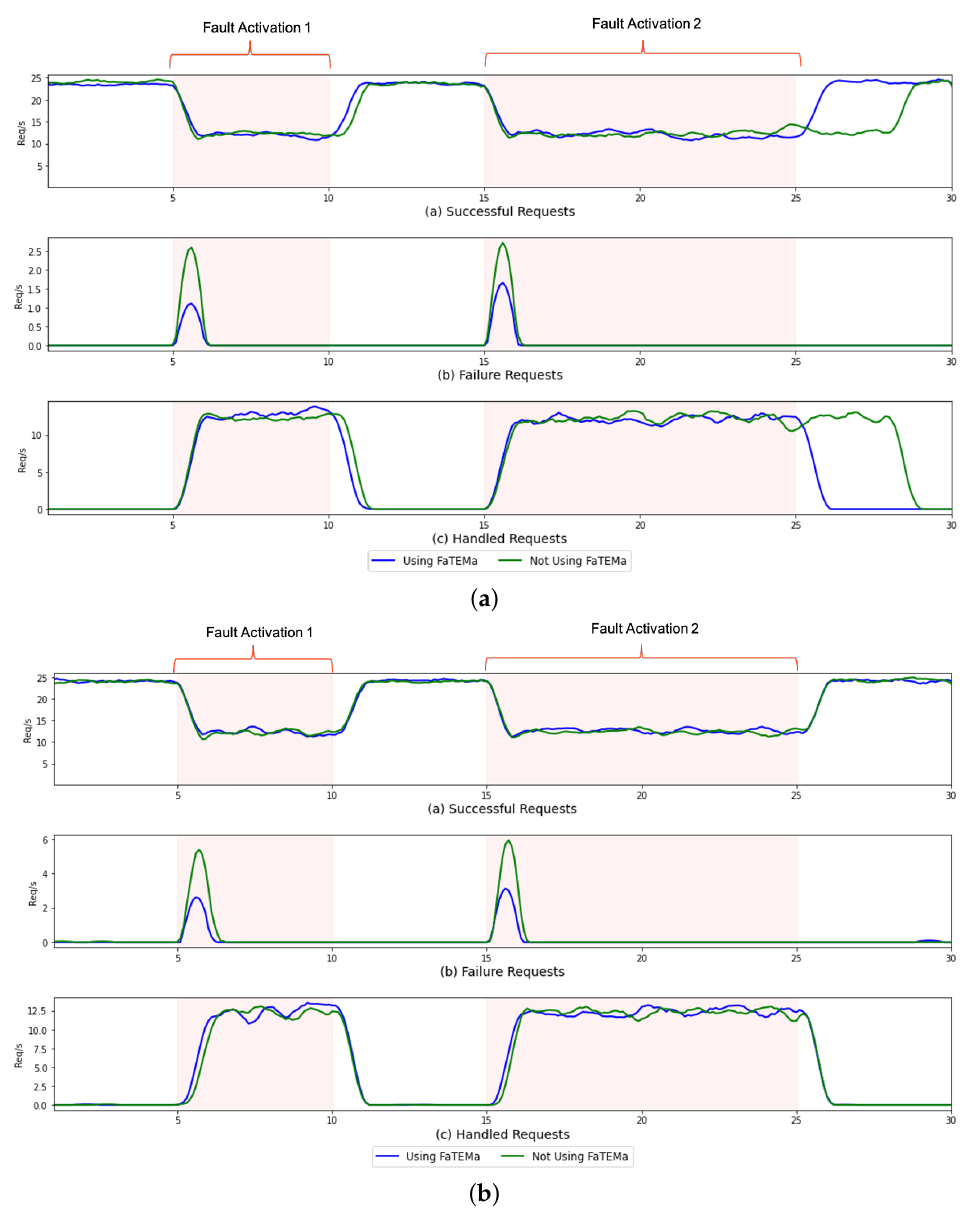
Figure 6. A comparison of the responses over time for each experimental scenario. ( a ) S#1—responses over time. ( b ) S#2—responses over